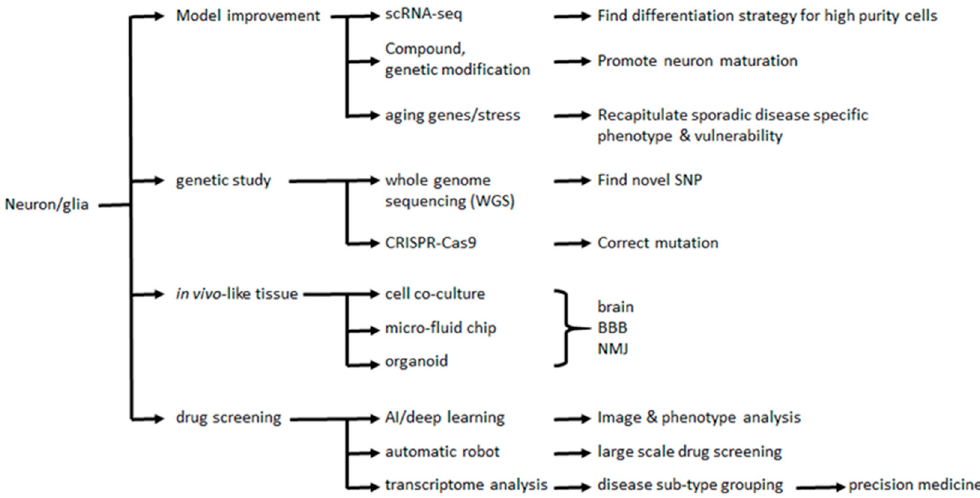
Figure 2. Combine novel technologies and iPSCs for disease model improvement, genetic studies, make complex neuronal organoids, and large-scale drug screening. scRNA: single cell RNA, SNP: single nucleotide polymorphism, BBB: blood–brain barrier, NMJ: neuromuscular